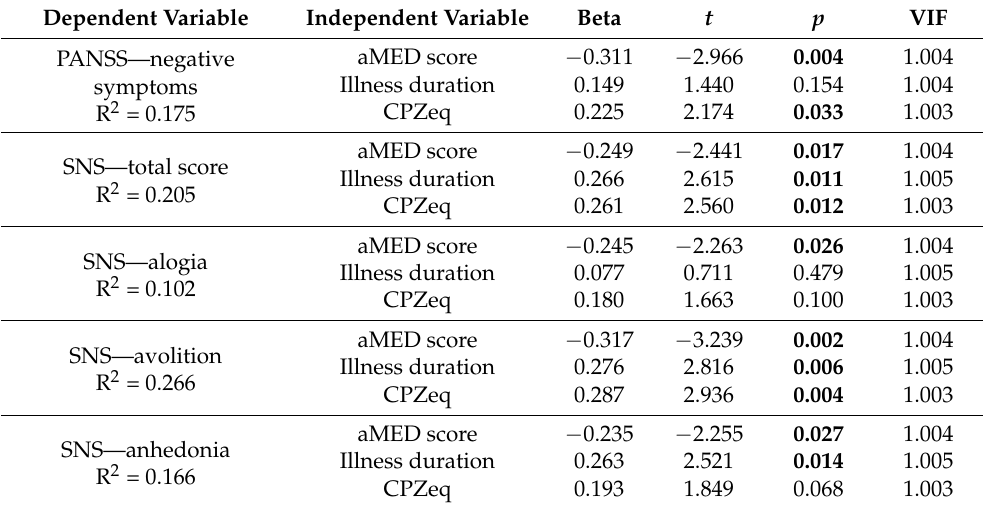
Table 4. Linear regression analyses for the association between the aMED score and negative